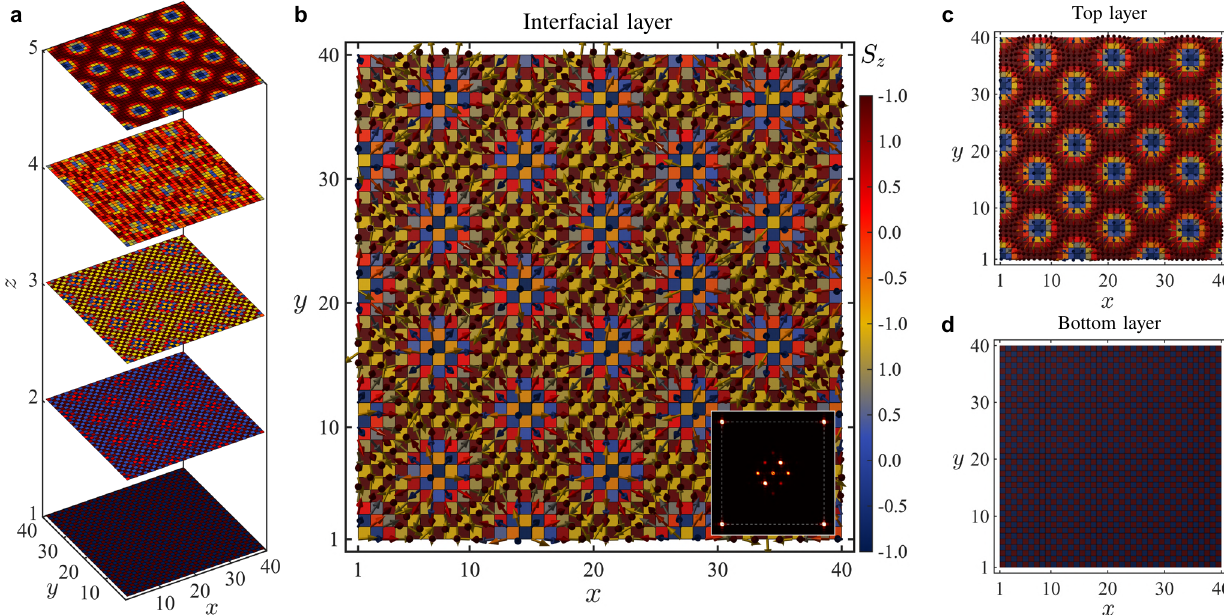
Fig. 4 Ferrimagnetic skyrmion crystal. a Plot of the z -component of the spin S z , obtained via MC annealing, in a fi ve-layer heterostructure. b Spin con fi guration of the IPF frustration-stabilized ferrimagnetic skyrmion crystal (FSkX), obtained via MC annealing at the central layer ( z = 3). c and d are skyrmion crystal and antiferromagnet con fi gurations at the top layer ( z = 5) and the bottom layer ( z = 1), respectively. The inset in b shows the spin structure factor S ( q ) within the fi rst Brillouin zone (denoted by the dashed lines), revealing a multi- q magnetic order. The parameters used are D = J , A z = 0.24 J , J = 1 (top layer), and D = 0, A z = 0, J = − 1 (bottom